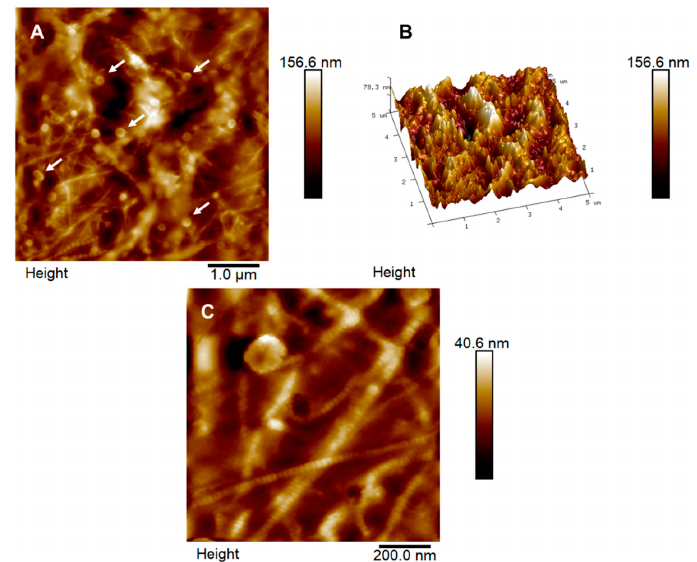
Figure 6. The surface of the human stroma ( A ) and its respective three-dimensional map ( B ) show the globular structures (white arrows) present in the topographic map in a 5 × 5 µm area. For more details on the stromal morphology, a topographic map with a 1 × 1 µm scan ( C ) shows the D-periodicity of collagen fibers.